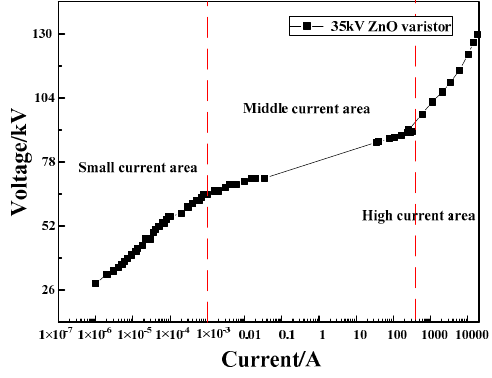
Figure 13. The voltage-current (V-I) curve of the ZnO varistor.